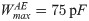
Scaling, robustness and time variability of the model.(A) Change of the mean period of the sequential dynamics as the number of clusters grows with: (i) the total number of excitatory neurons kept constant (red line); (ii) the total number of neurons increasing with cluster size (blue line). Error bar shows a standard deviation. (B) Dynamics with varying level of external excitatory input for four different cluster sizes and NE = 2400. The external input can modulate the period of the sequential dynamics by ∼ 10%. (C) Recall performance of the learned sequence ABCBA for varying cluster sizes and NE = 30NC under synapse deletion (computed over 20 repeats). The learning time depends on the cluster size: Δt = 960s/NC. (D) The ABCBA sequence is learned with a network of 120 excitatory neurons connected in one large chain and read-out neurons with maximum synaptic read-out strength increased to WmaxAE=75pF. The network is driven by a low external input (rextEE=2.75kHz). When, at t = 500 ms a single synapse is deleted, the dynamics breaks down and parts of the sequence are randomly activated by the external input. Top: spike raster of the excitatory neurons of the RNN. Bottom: spike raster of the read-out neurons. (E) (Left) Histogram of the variability of the period of the sequential activity of the RNN over 79 trials (Right) The standard deviation of the cluster activation time, σt, increases as the square root of μt, the mean time of cluster activation: σt=0.213μt (root mean squared error = 0.223 ms).